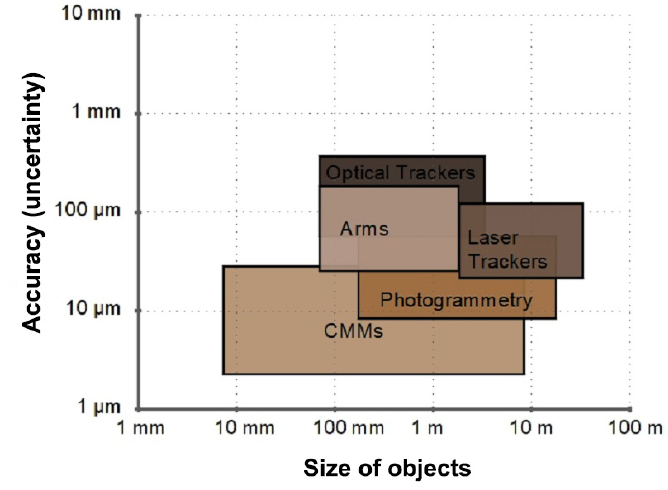
Figure 3. Accuracy ranges of EFR hardware technologies.